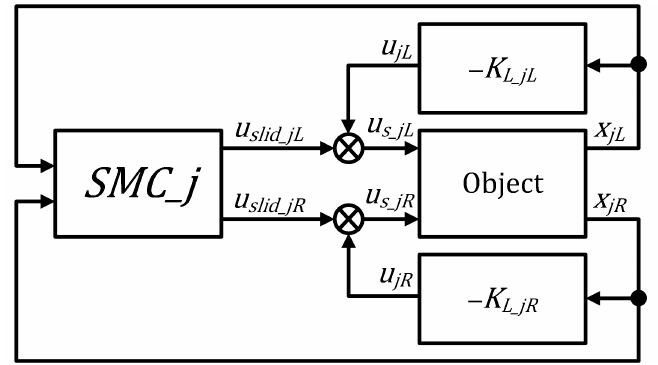
Figure 2. Advanced sliding mode controller (ASMC) block diagram of the system with anti-roll SMC controller and controllers of left and right strut linear regulators with quadratic performance index (LQR).